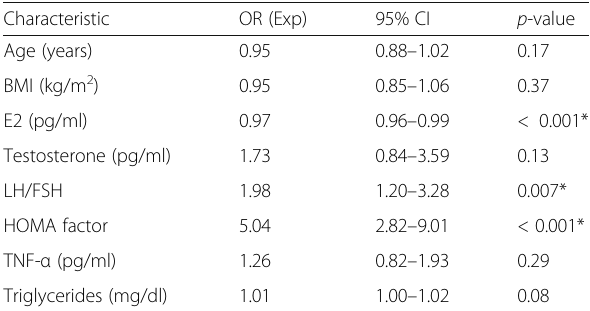
Table 4 Multiple Logistic Regression Analysis of Participants ’